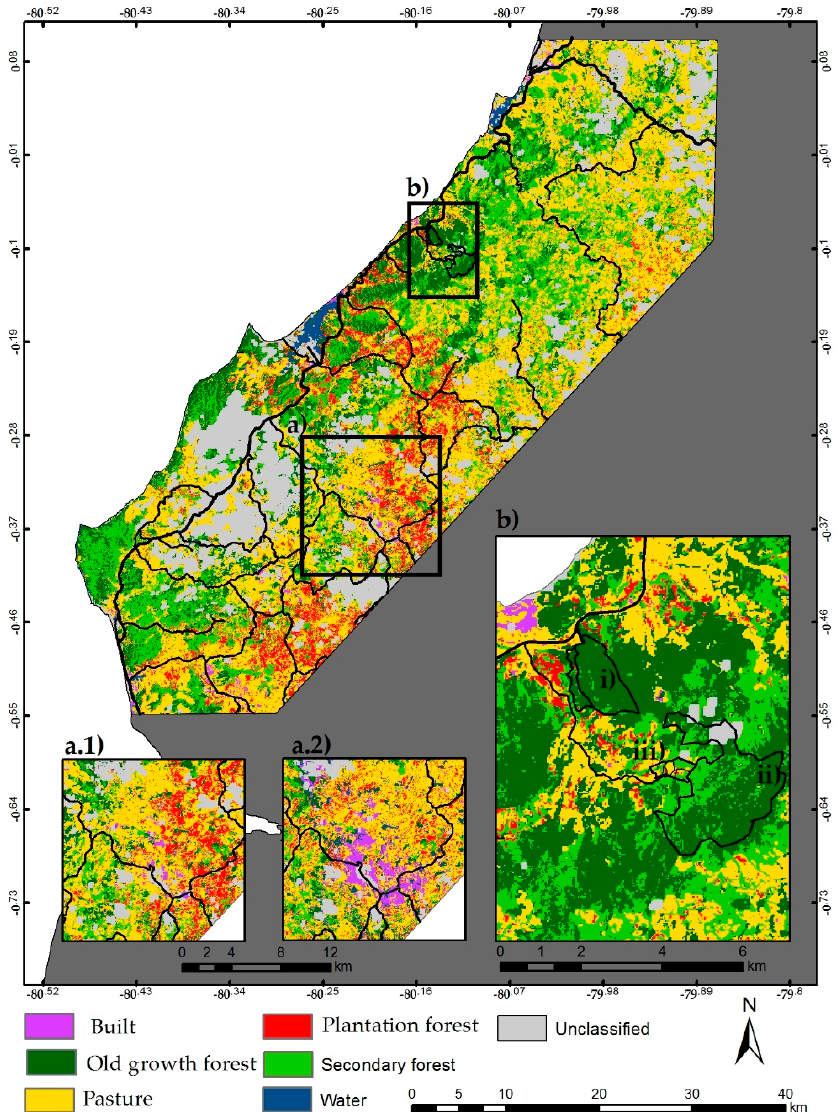
Figure 6. Final Random Forests (RF) land cover classification map using predictor variables from the dry and wet seasons. Inset map ( a ) shows areas of conflicting classification between the dry season (a.1) and bi-seasonal (a.2) models. Inset map ( b ) show the location of (i) Lalo Loor reserve, (ii) Jama Coaque reserve, iii) Jama Coaque areas of reforestation, native tree planting and pasture. Lines indicate primary, secondary, and tertiary roads.